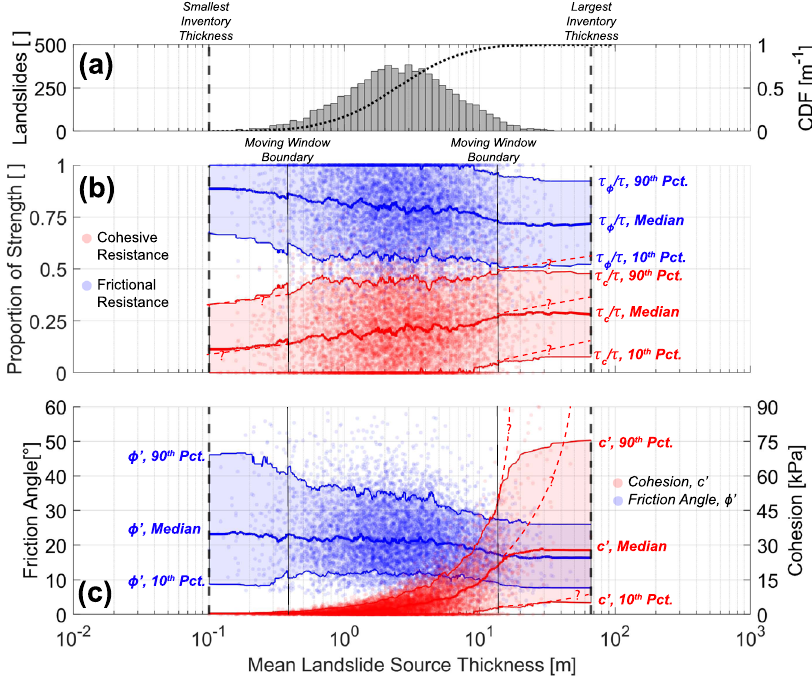
Fig. 3 | Exchange in strength with landslide size. a Histogram and cumulative distribution function(CDF)of landslidesby mean thickness. Approximately25% of landslides have a mean thickness of <1m (predominantly soil), while 70% have mean thicknesses of 1 – 10m (predominantly saprolite, weathered bedrock and potentially fresh bedrock). b Proportion of total shear strength attributed to cohesion and friction in comparison to landslide thickness. The shaded areas represent the bounds between 10th and 90th moving percentiles (300 point